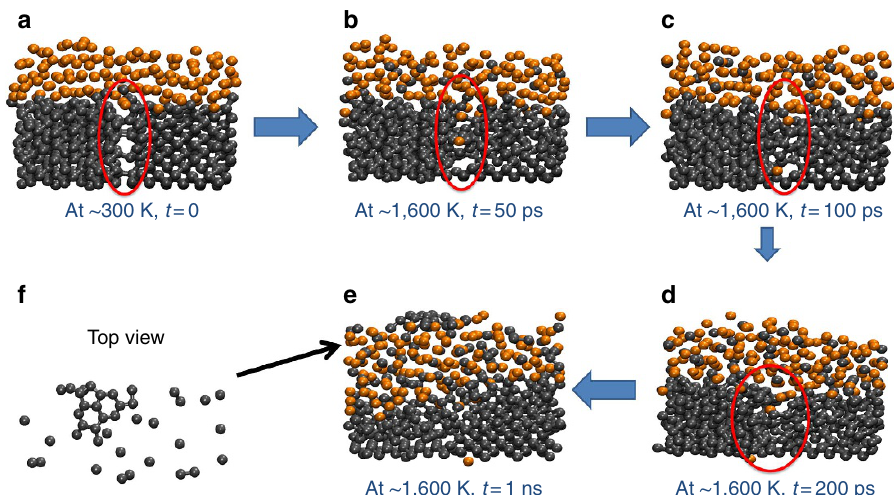
Figure 8 | Carbon diffusion through the diamond grain boundaries mechanism. Carbon diffusion through the nickel film and eventual segregation of nickel through diamond grain boundaries is highlighted through MD simulations: ( a ) initial configuration shows nickel film on two diamond grains, ( b ) heating up to 1,600K for 50ps indicates segregation of nickel atoms through the grain boundary, ( c ) at 100ps one nickel atom diffuses all the way down to the bottom of diamond, ( d ) more nickel atoms segregate at 200ps and top layer of diamond starts to graphitize, ( e ) indicates the formation of graphitic layer on top of nickel, and ( f ) top view depicts the formation of graphene rings. Carbon atoms are represented by dark grey colour, while nickel atoms by dark orange colour. Red oval highlights the grain boundary.